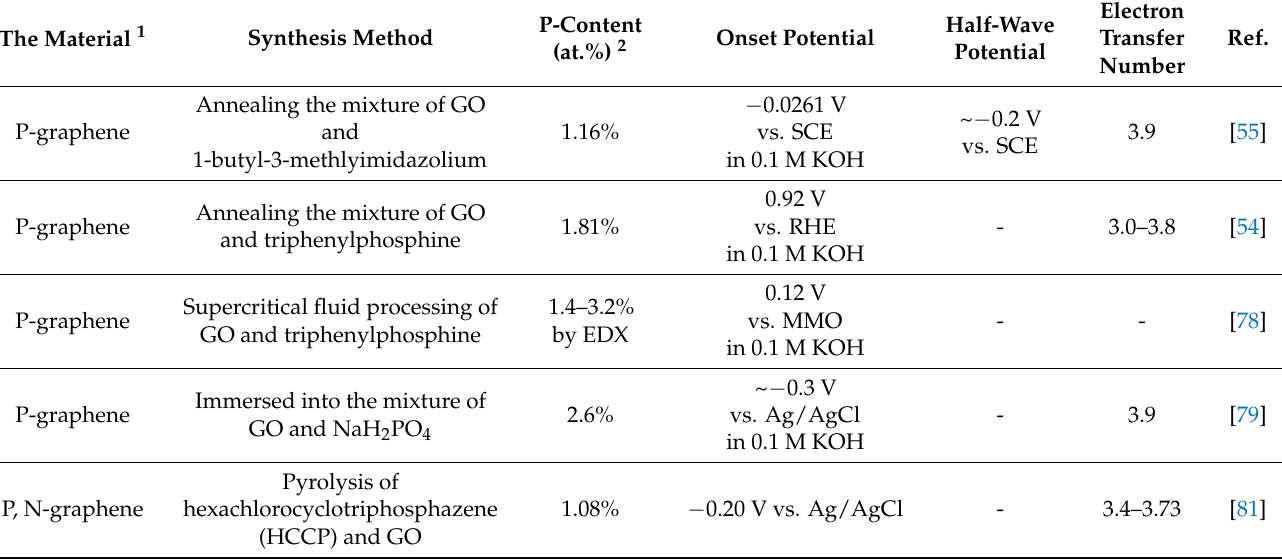
Figure 5. The simulation of different models of P-doped graphene for ORR performance. Reproduced with permission from [80]. Copyright © 2022, American Chemical Society. Table 1. Summary of some typical works dedicated to P-graphene for ORR.